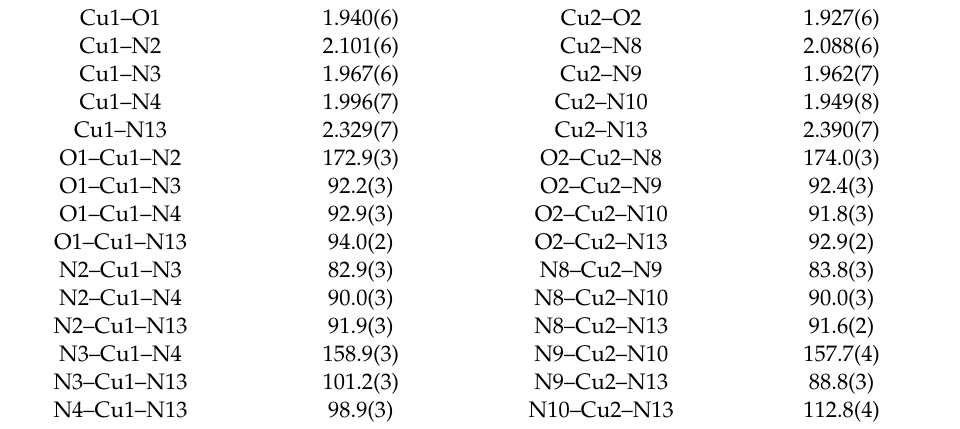
Table 2. Selected geometrical parameters (distances / Å and angles / ◦ ) for 1 .